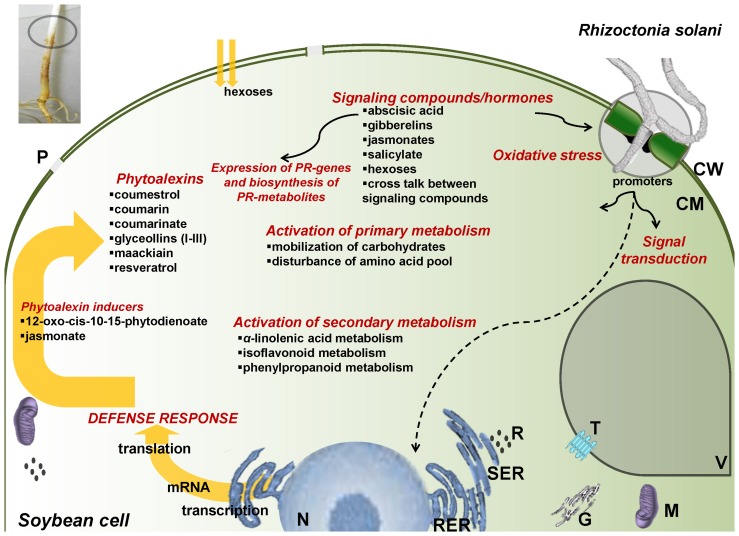
Proposed graphical model for the role of Rhizoctonia solani in activation of soybean defense mechanisms.[CM; cell membrane, CW; cell wall, G; Golgi body, M; mitochondrion, N; nucleus, P; plasmalemma, R; ribosomes, RER; rough endoplasmic reticulum, SER; soft endoplasmic reticulum, T; transporters, V; vacuole].